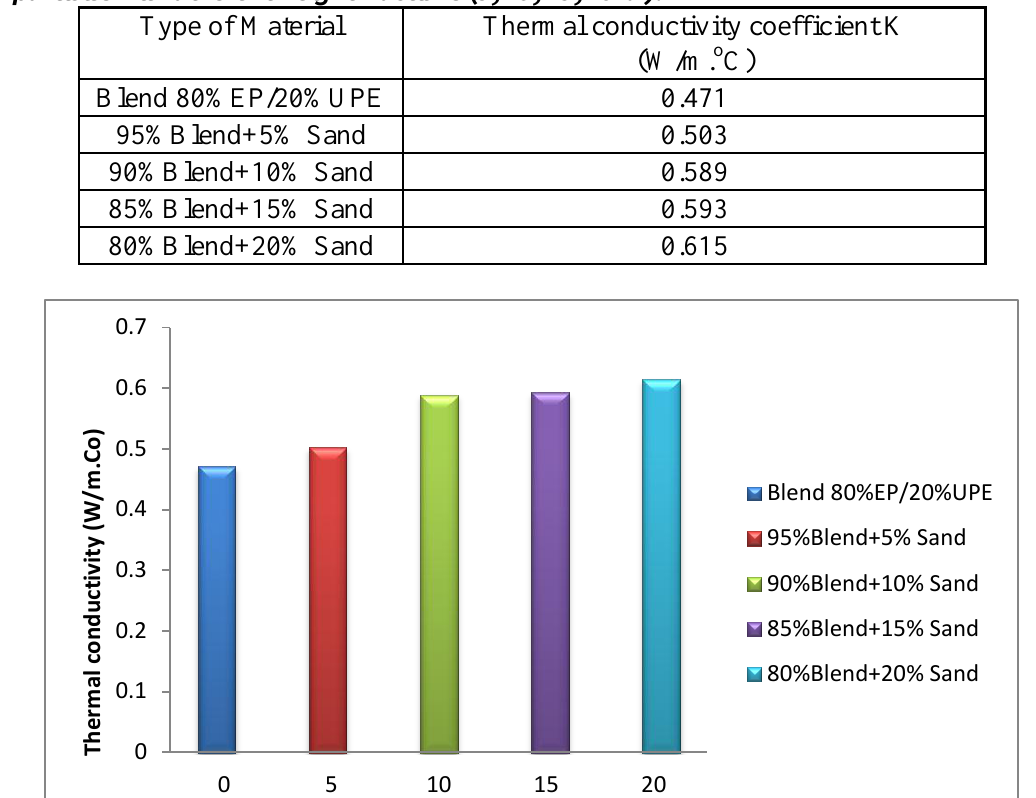
Table 4: Values of thermal conductivity coefficient of EP/UPE reinforced with sand- particles with different weight fractions (5, 10, 15, 20 %).